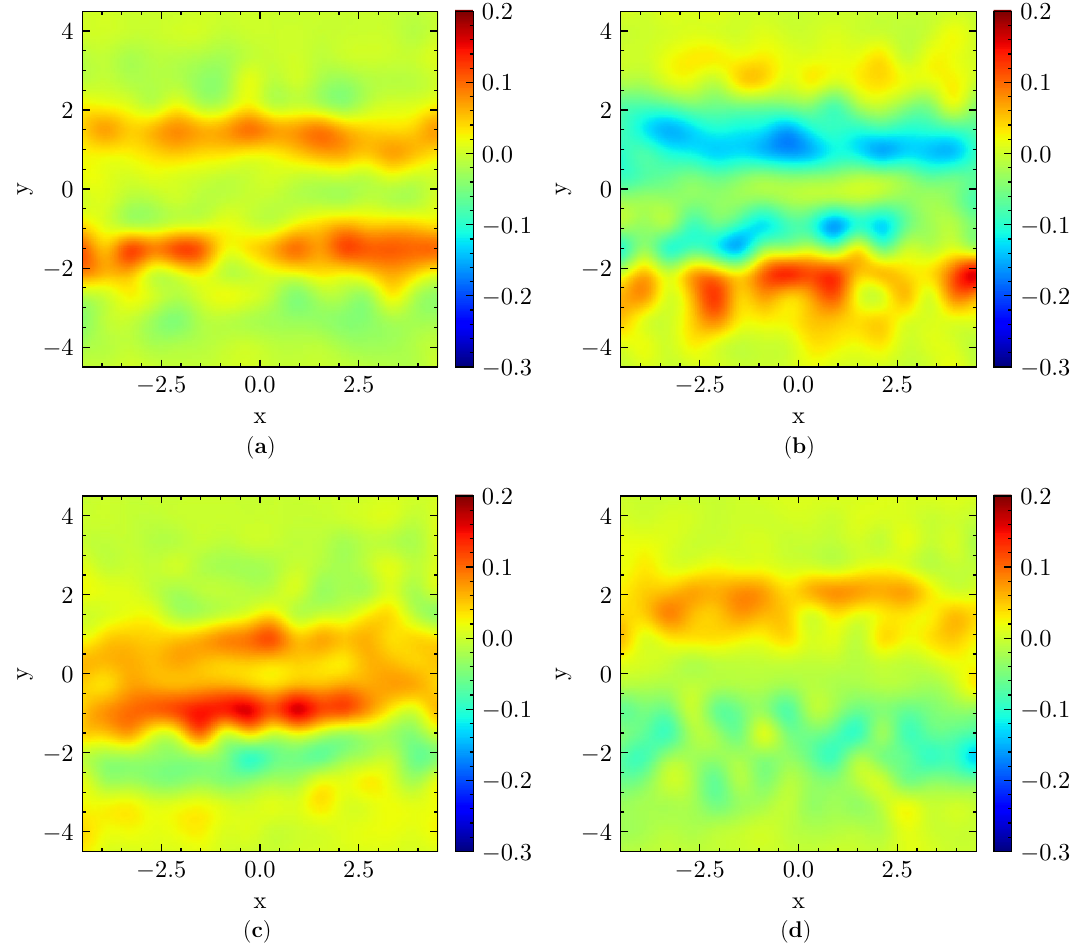
Figure 3. 2D probability distribution of individuals’ position ¯ r relative to overall average. Positions are shown in the group-centered reference frame and the x axis is aligned with the direction of motion of the group. Each sub-figure depicts the difference between the distribution relating to a certain social relation and an unweighted average concerning all social relations. ( a ) Colleagues, ( b ) couples, ( c ) families, ( d ) friends. The color scales are adjusted for highlighting the